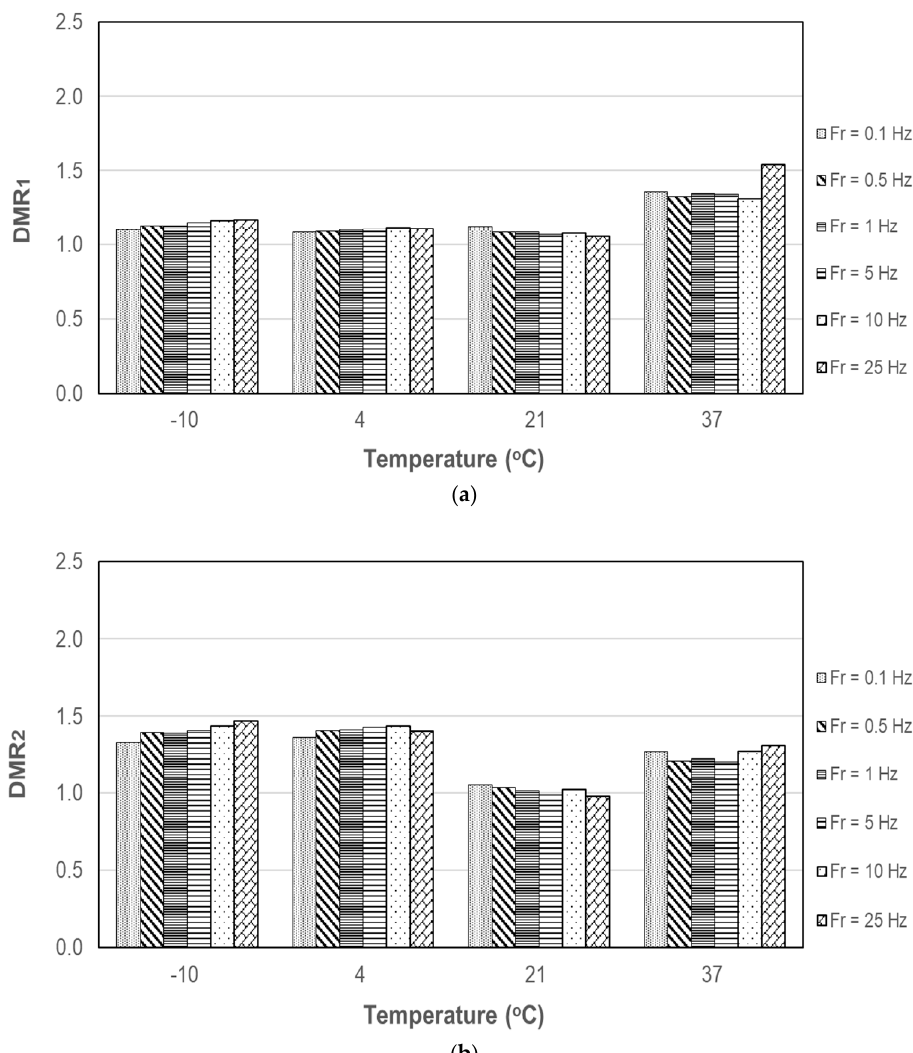
Figure 7. DMR of PA10: ( a ) after first cycle conditioning; ( b ) after second cycle conditioning.